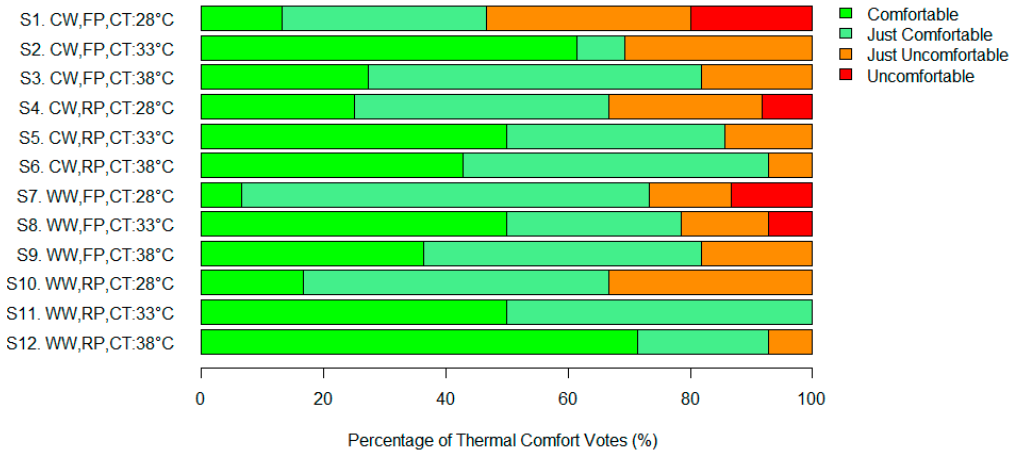
Figure 8. Percentage of overall thermal comfort votes divided into 4 scale points, from “uncomfortable” to “comfortable”, in response to 12 different experimental scenarios. S1 to S12 are the twelve scenarios presented in Figure 2 and Table 3. CW and WW denote cool and warm window; FP and RP stand for the front and rear positions; and CT is the ceiling temperature.